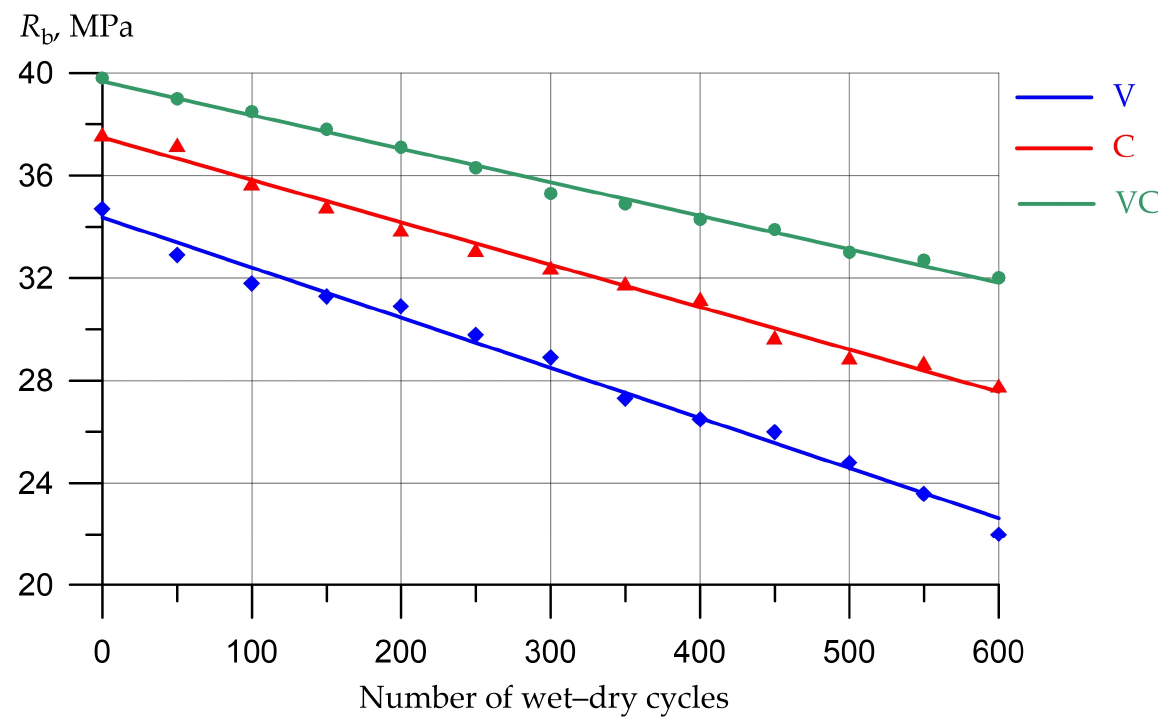
Figure 9. Dependence of the change in prism compressive strength of vibrated, centrifuged, and vibrocentrifuged concretes on the number of moistening and drying cycles at pH 5.